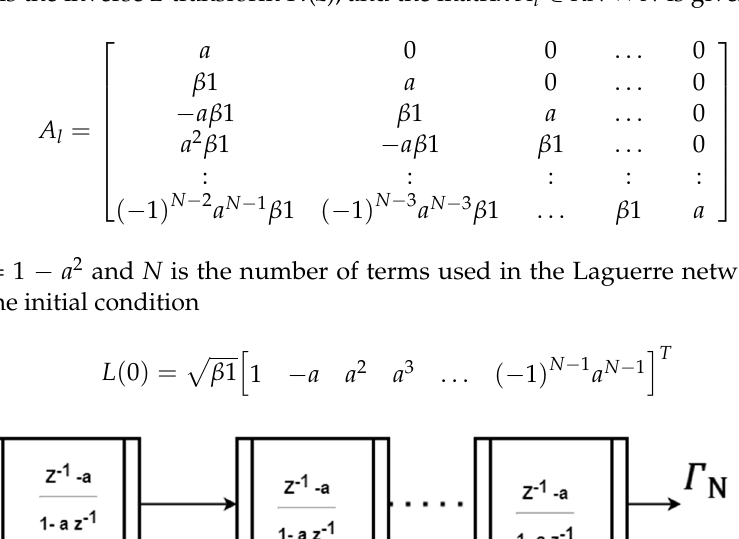
Figure 6. Flowchart of the neuro-predictive control.